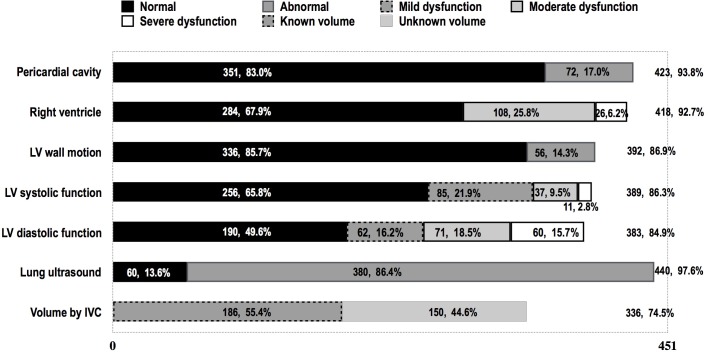
Completion proportion and findings of ultrasound examination on admission.